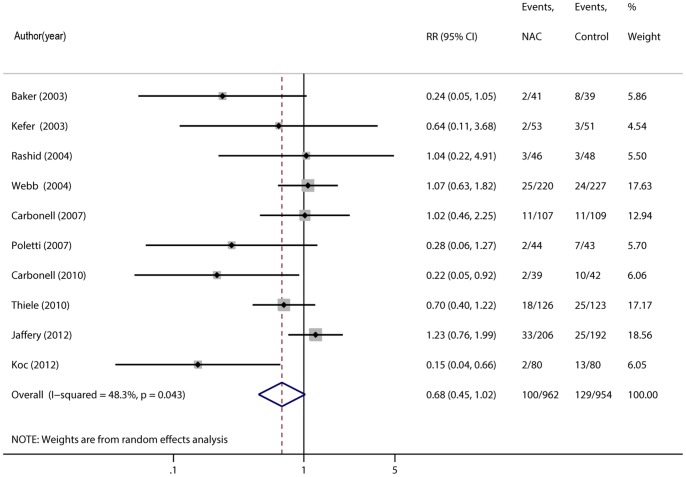
Forest plot of risk ratios (RRs) and 95% confidence intervals (CIs) for the incidence of contrast-induced acute kidney injury in patients assigned to intravenous NAC therapy versus control.Abbreviations: NAC, N-acetylcysteine; RR, risk ratio; CI, confidence interval.